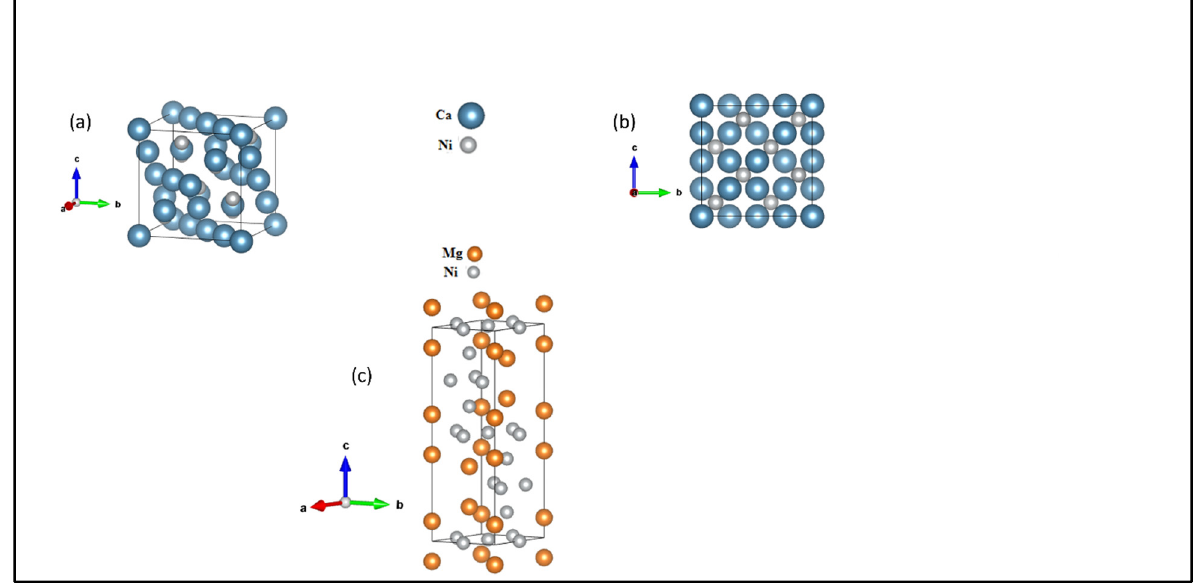
Figure 1. Crystal structures of ( a , b ) CaNi 2 ( c ) MgNi 2 .